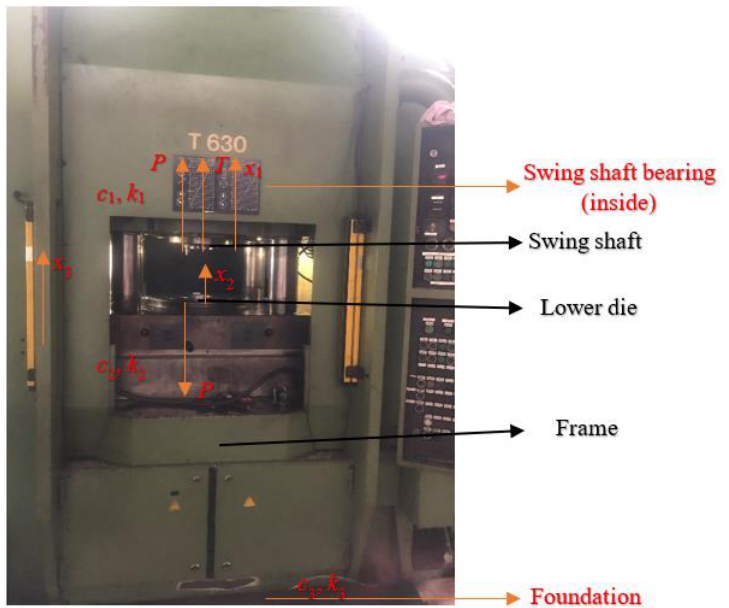
Figure 1. The structure of a T630 COF machine.